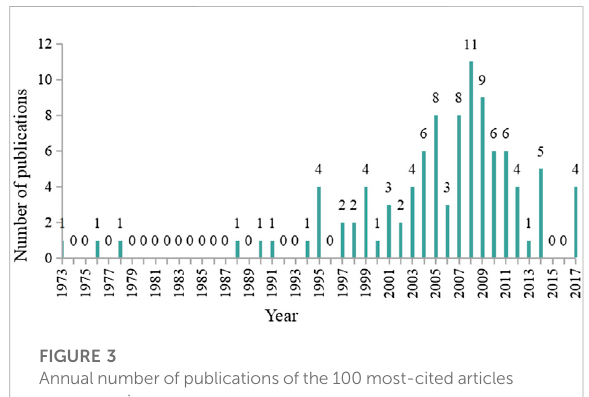
FIGURE 3 Annual number of publications of the 100 most-cited articles on